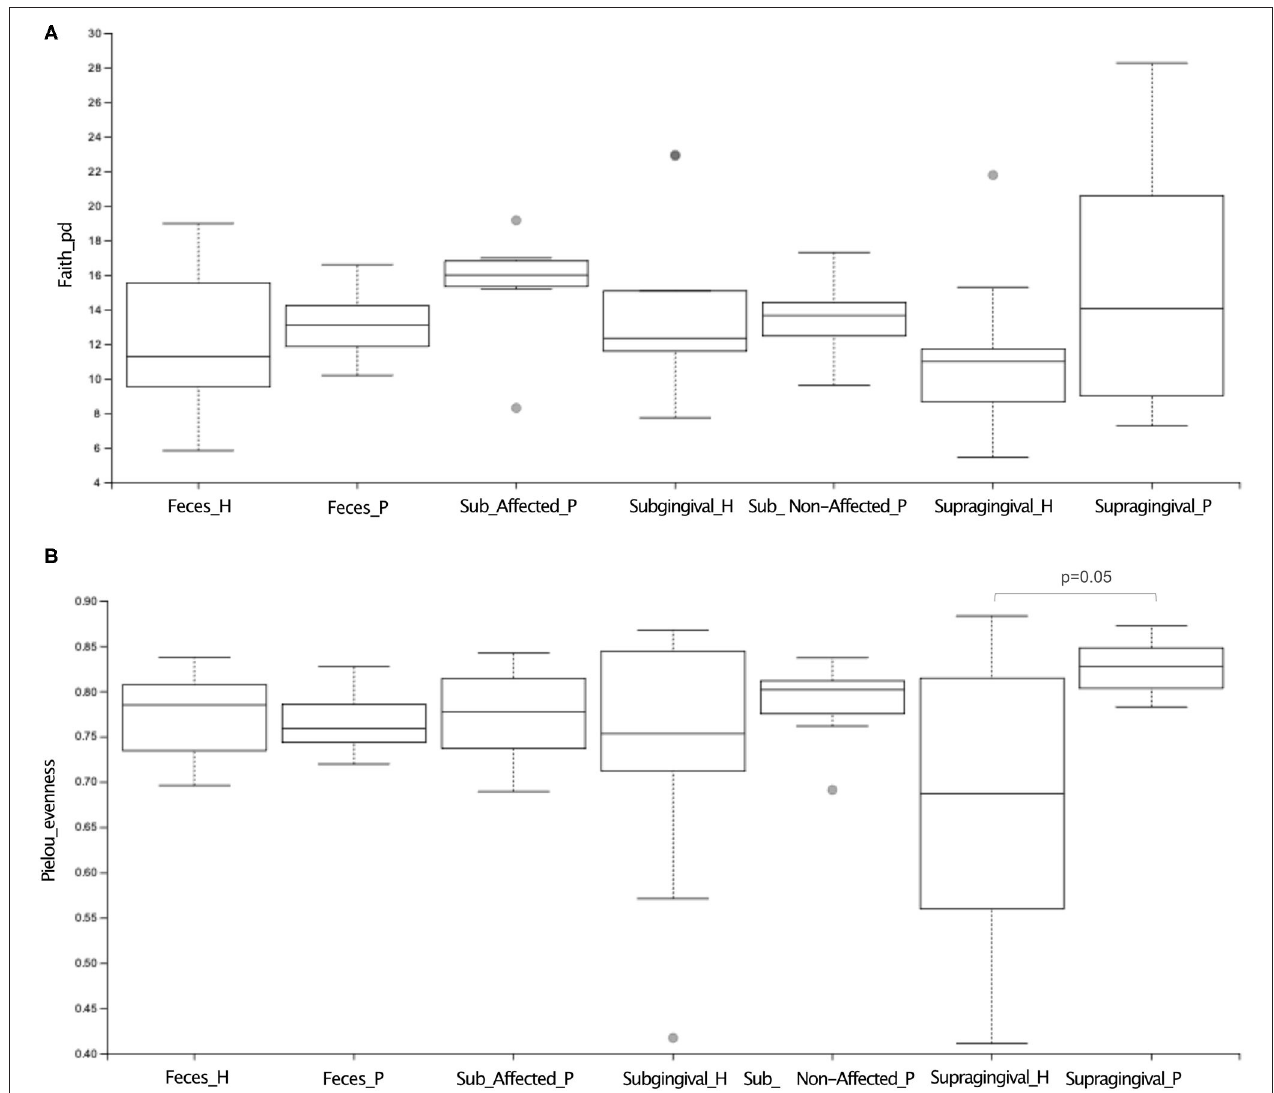
FIGURE 1 | Alpha diversity analysis of microbiome of oral (supragingival, subgingival non-affected sites; subgingival affected sites) and fecal samples of periodontitis (P) and health (H) subjects. In (A) richness (Faith’s PD) index and (B) evenness (Pielou) index analysis. Differences were considered significant when p ≤ 0.05 using Wilcoxon-Mann Whitney test.